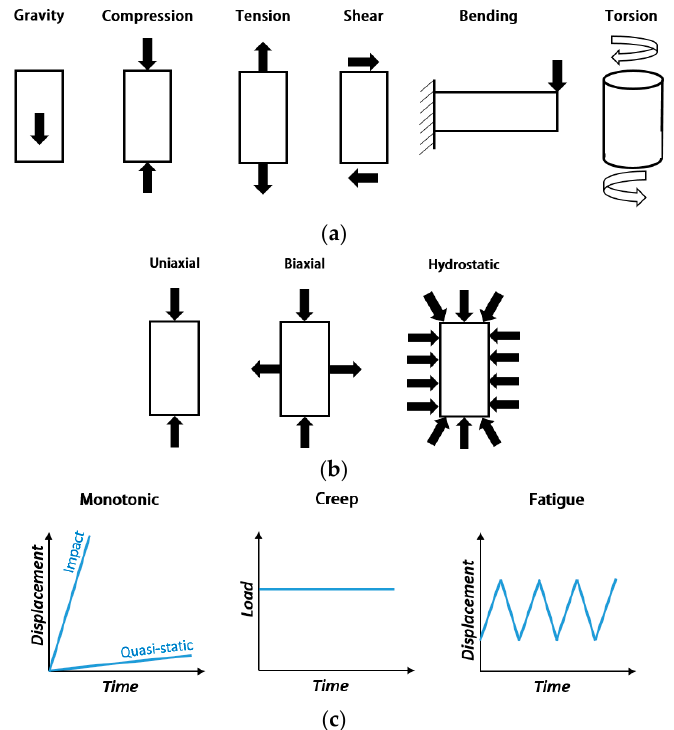
Figure 18. A proposed classification for loading conditions: ( a ) loading type, ( b ) loading direction and ( c ) period of application, first published by the authors in [9].